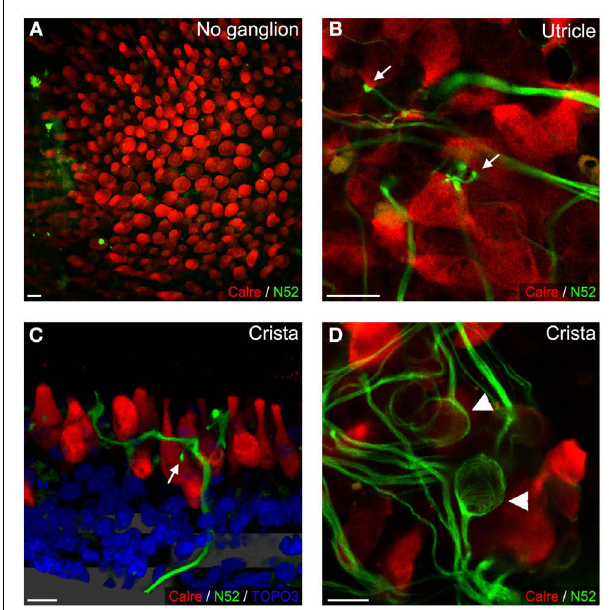
FIGURE 2 | Sensory epithelial innervation in rat co-cultures. After 3DIV, no neurites were observed in P2 utricles cultured alone (A) . Conversely, at 6DIV in the presence of P3 vestibular ganglion, neurites penetrated sensory epithelia and contacted hair cells (B) . In utricles and cristae (P5, 10DIV), bouton-like contacts were observed [ (B,C) ; arrows], while calyceal innervation was only observed in cristae [ (D) , with arrowheads]. Neurofilament (green), hair cells (red), and occasionally nuclei (blue) were stained. Scale bars 10 μ m.